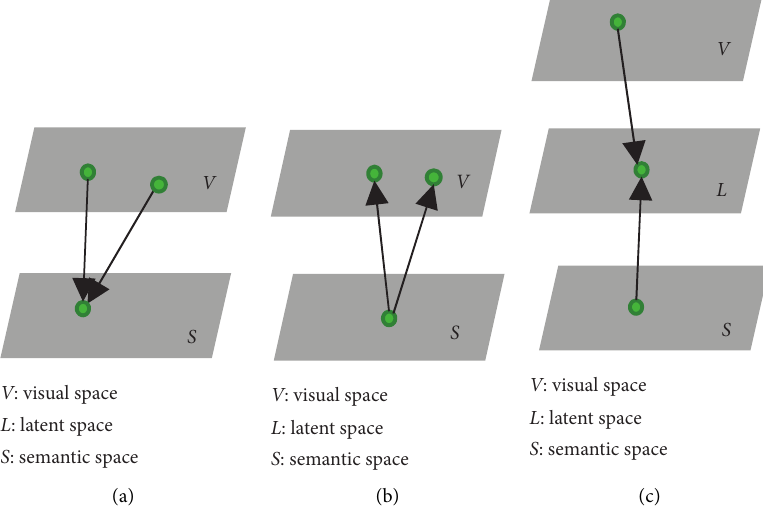
Figure 1: Three mapping methods commonly used in zero-shot learning. (a) Mapping from the visual space to the semantic space. (b) Mapping from the semantic space to its visual space. (c) Mapping both semantic features and visual features to a shared latent space.